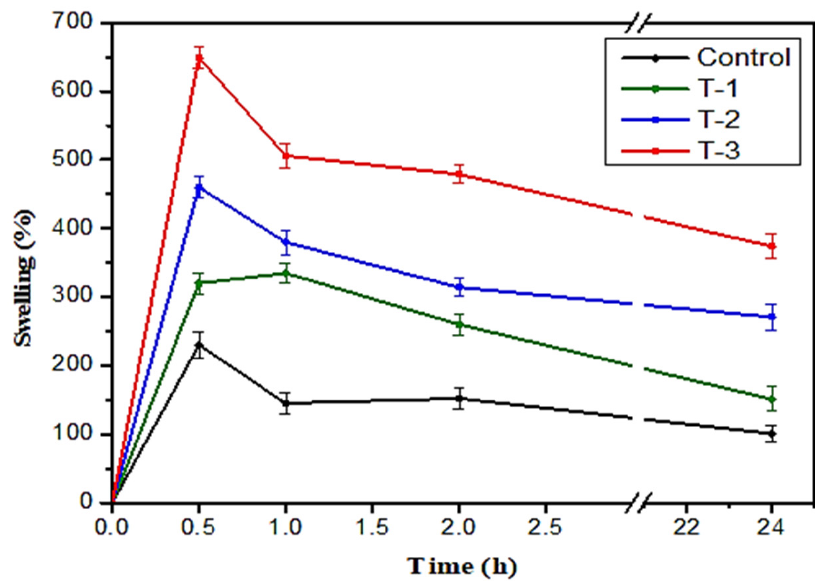
Figure 3. The swelling trend of sodium alginate (SA)- Raphanus sativus L. seed extract (SE) hydrogels at 0.5, 1, 2, 3, 12, and 24 h in NaCl solution. Control; T-1: (SA:SE 70:30); T-2: (SA:SE 80:20); and T-3: (SA:SE 90:10).